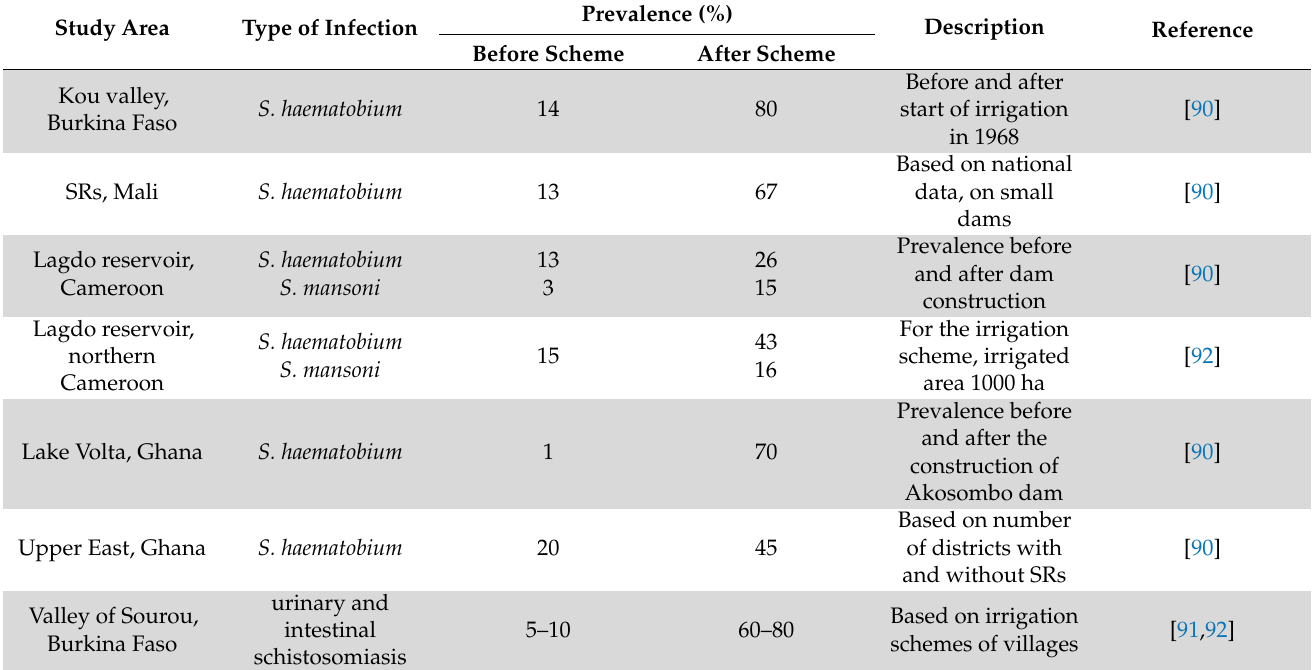
Table 12. Prevalence of schistosomiasis around SRs and irrigation